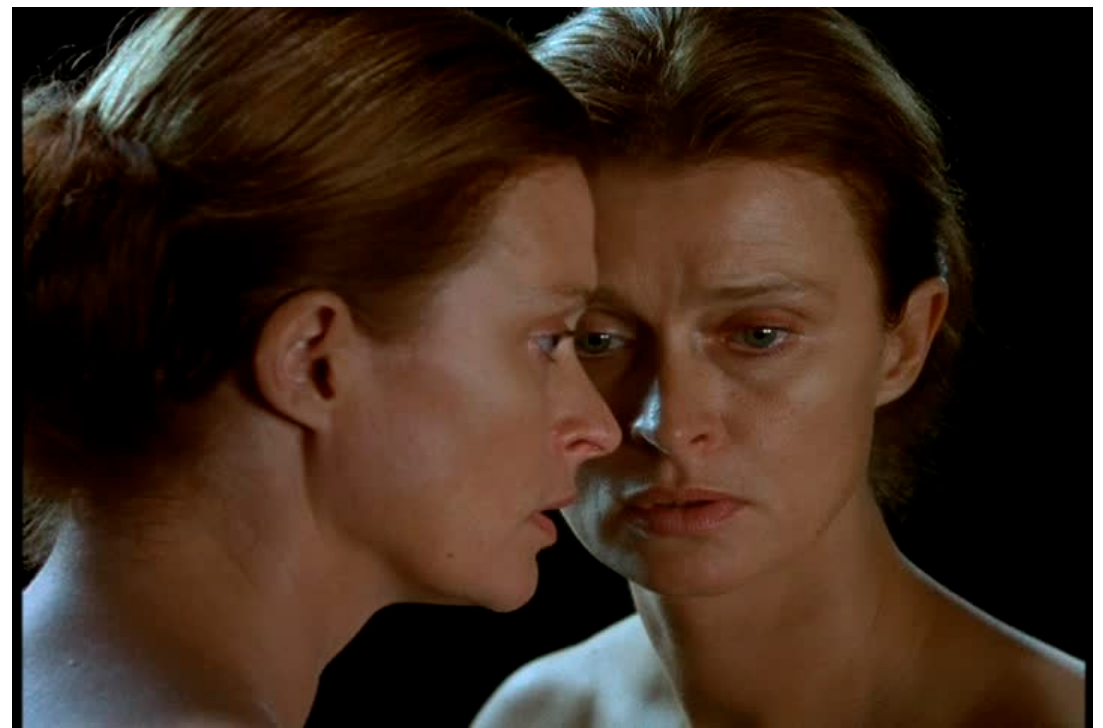
Figure 3. Marianne battles with herself, Isabelle in the midst.